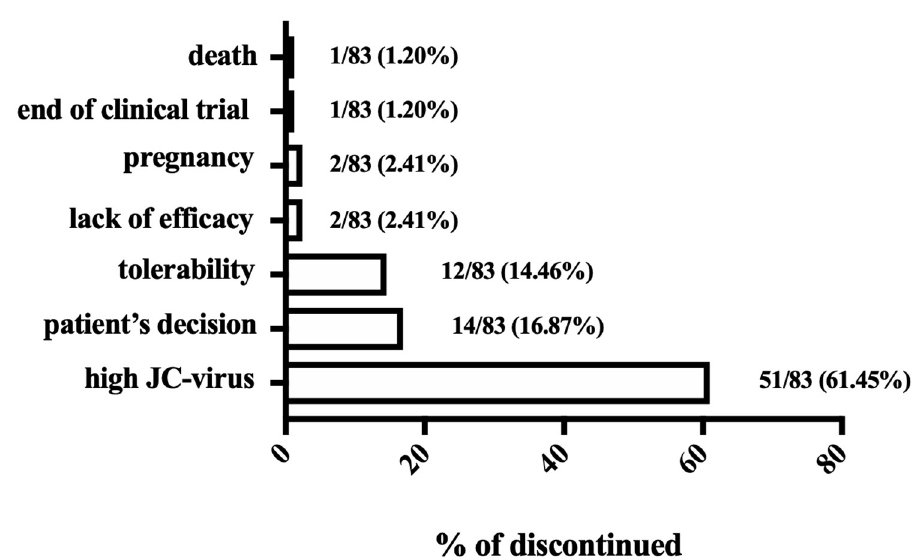
Fig 2. Reasons for natalizumab discontinuation. JC-virus—John-Cunningham virus.